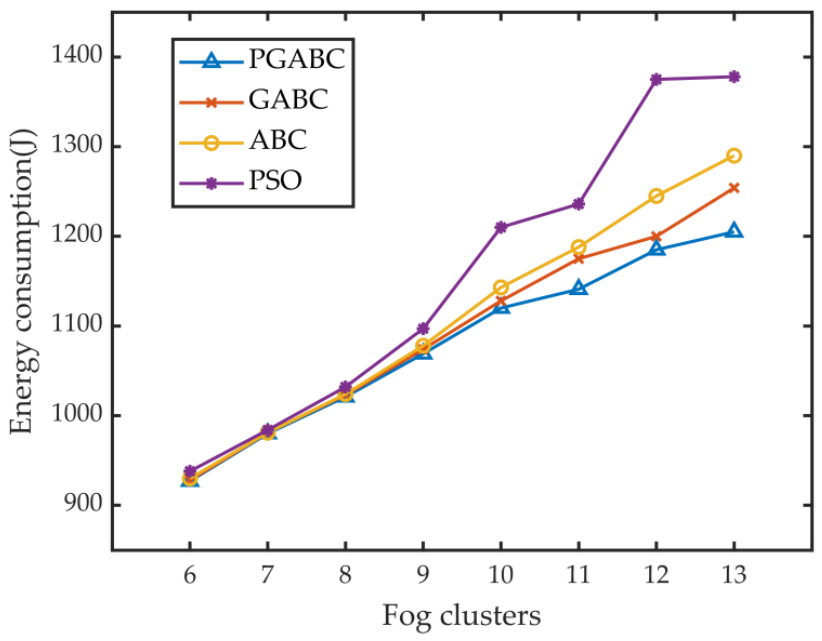
Figure 14. Total energy consumption for the four algorithms varying with fog cluster number.